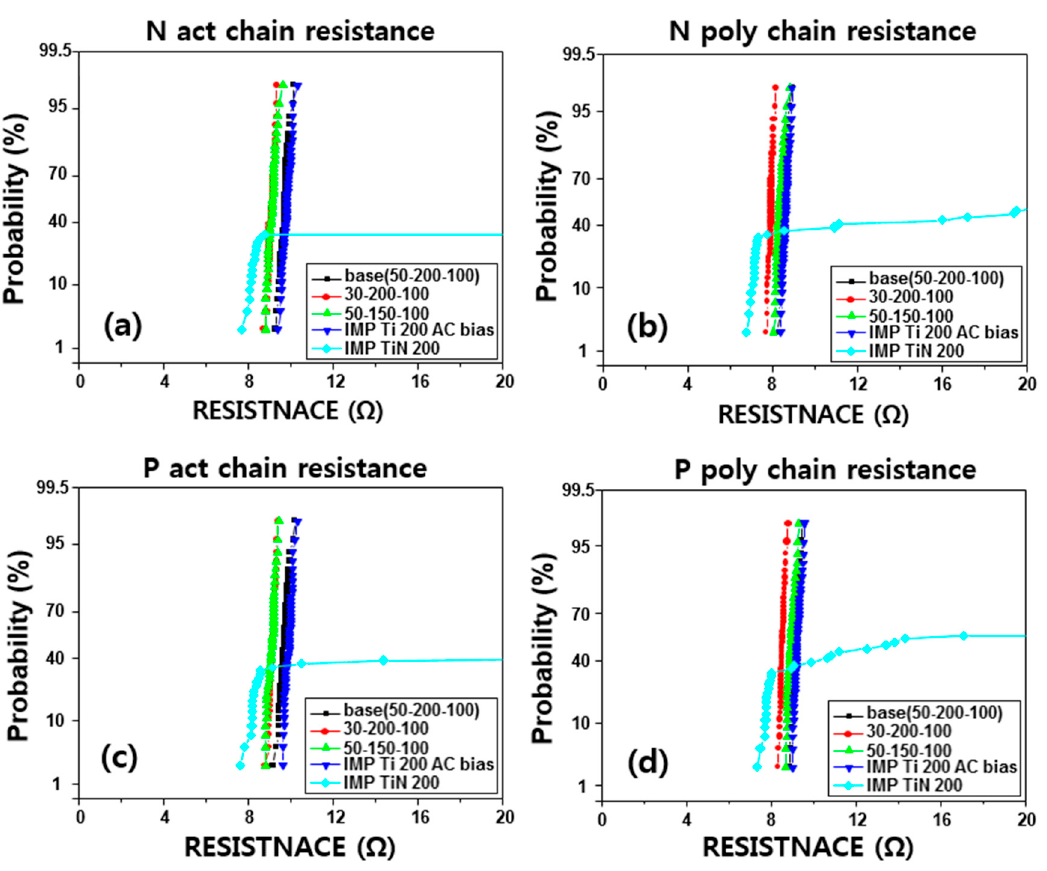
Figure 9. Electrical properties of ( a ) N act chain, ( b ) N poly chain, ( c ) P act chain, and ( d ) P poly chain contact resistance (chain type) (unit: Å).